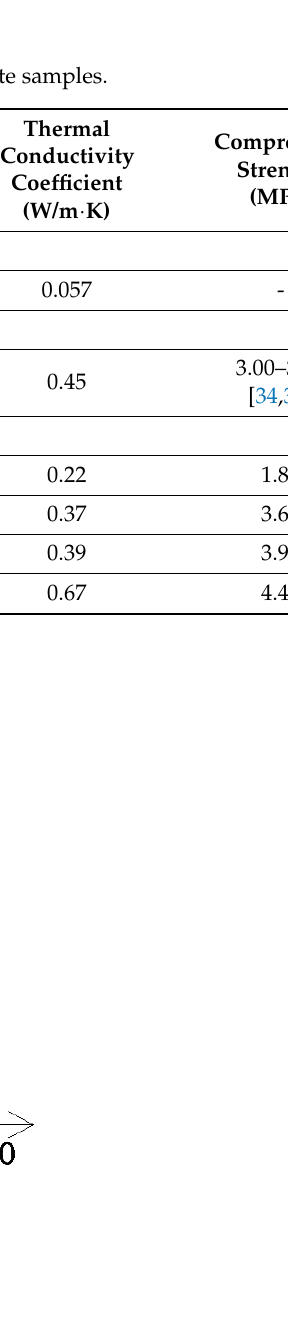
Figure 3. Dependency of the thermal conductivity coefficient on the bulk density of perlite and leca concrete blocks; 2* value determined based on [30,31].